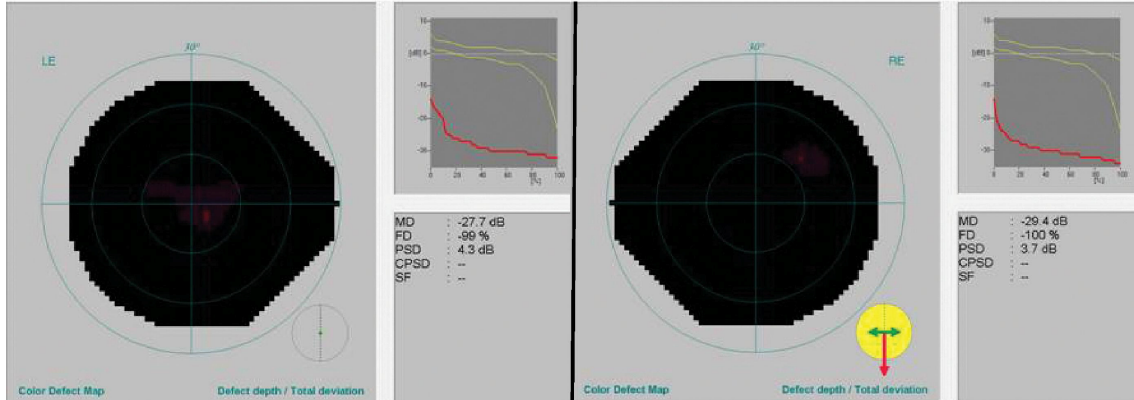
Figure 1: Automated perimetry at presentation demonstrating severely disturbed central visual fields (RE: right eye, LE: left eye).